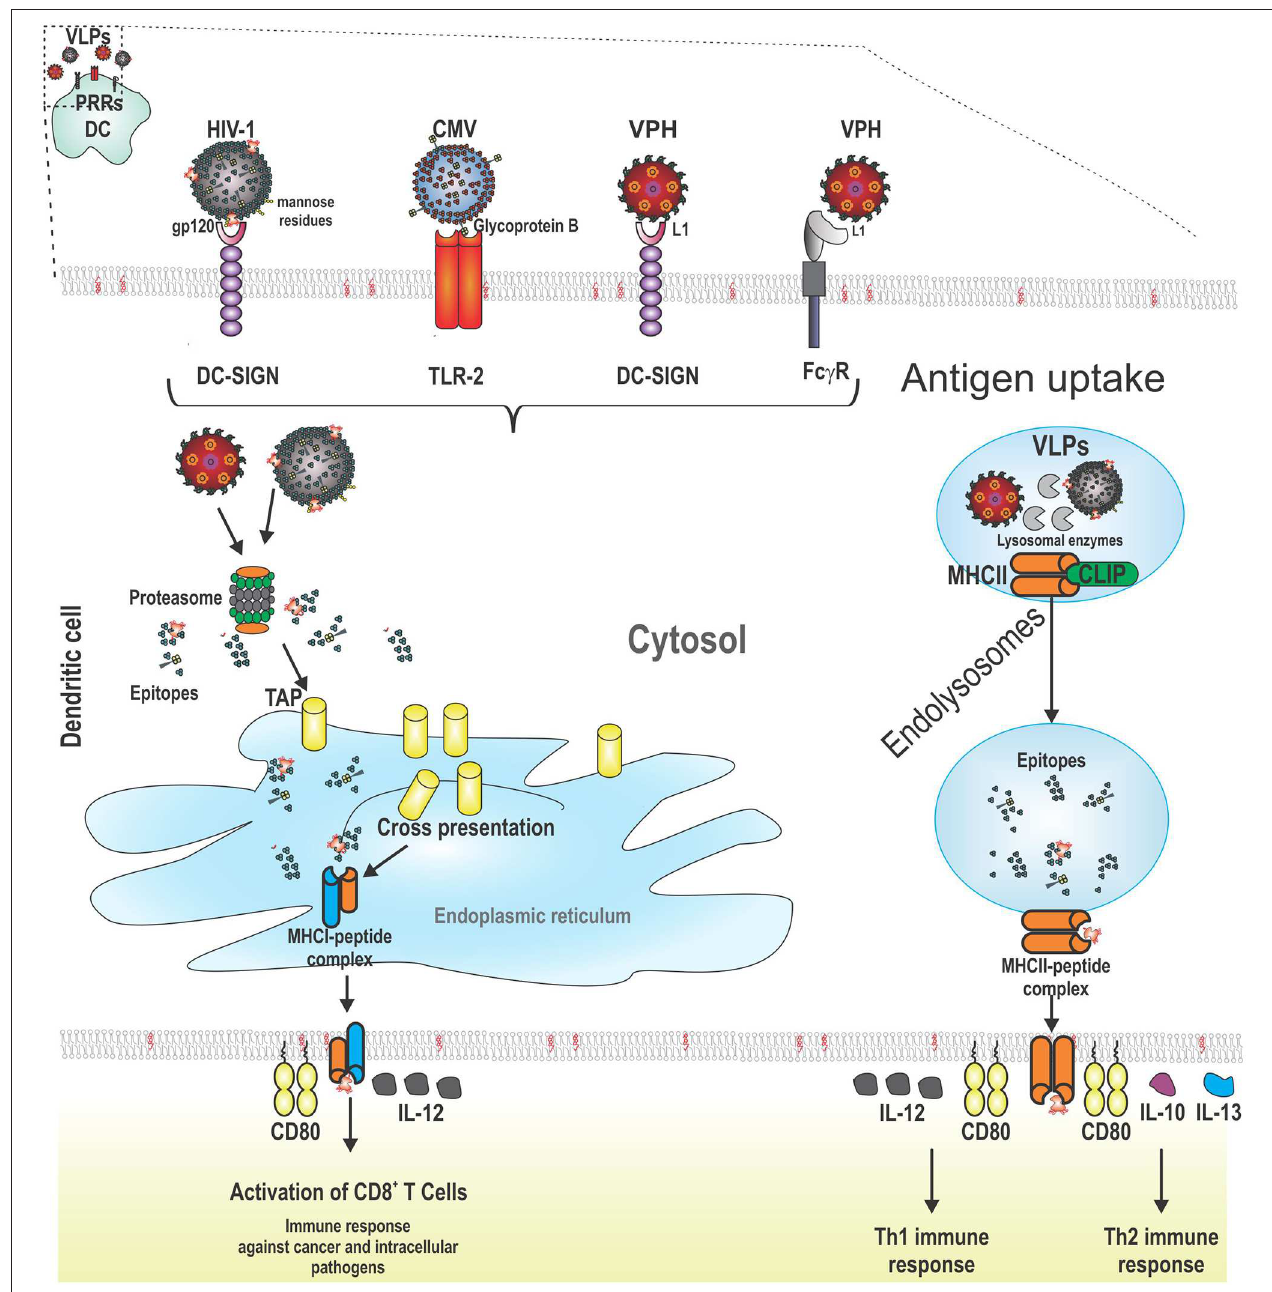
FIGURE 2 | Schematic representation of the interaction between pattern recognition receptors (PRRs) from dendritic cells (DCs) and VLPs. VLPs are recognized by PRRs from DCs (CLRs, TLRs, and FC γ R). After this, VLPs are taken up by receptor-mediated endocytosis. VLPs are processed for the presentation of their epitopes through cross-presentation or MHCII. For cross-presentation, VLPs reach the proteasome, are degraded into the cytosol, and the short peptides derived from VLPs are transported to the endoplasmic reticulum by TAP (transporter associated with antigen presentation). MHCI-epitope complexes are moved to the cell surface from DCs to stimulate CD8 + T cells which induce lysis of cancer cells or cells infected by intracellular pathogens. The other pathway for antigen presentation is through MHCII molecules. In this case, VLPs are processed into short peptides by lysosomal proteases. In the meantime, the variant chain (li) is processed and loaded into MHCII molecules (class II associated li derived peptides, CLIPs) until their exchange by VLP epitopes. Later, the MCHII-epitope complexes are moved to the cell surface from DCs to stimulate CD4 + T cells which help B cells to produce antibodies or to CD8 + T cells to enhance their cytotoxicity. Additionally, two signals are required for full activation of adaptive immune system cells: costimulatory molecules (such as CD80) and cytokines (such as IL-12 for CD8 + T cells and Th1 cells; and finally, IL-10 and IL-13 for Th2 cells).